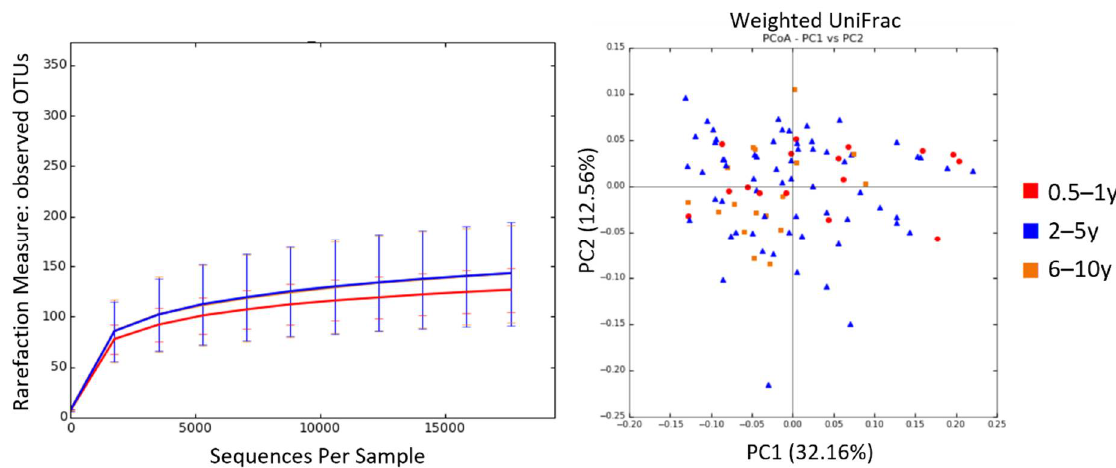
Figure 3. Alpha and beta diversity according to dog age group. Microbial richness was measured based on observed OTUs ( left ). PCoA was performed based on weighted UniFrac distances ( right ).